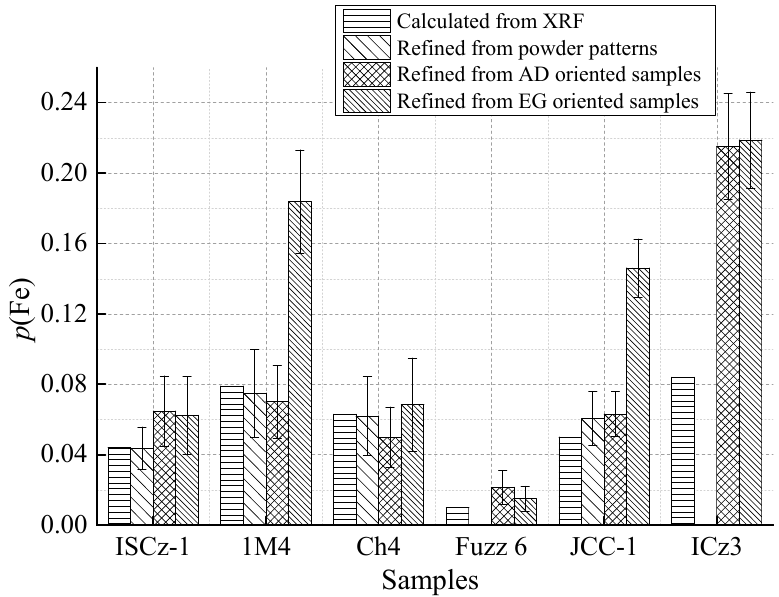
Figure 8. Refined values of occupancy of iron p (Fe), compared to the values obtained by the XRF